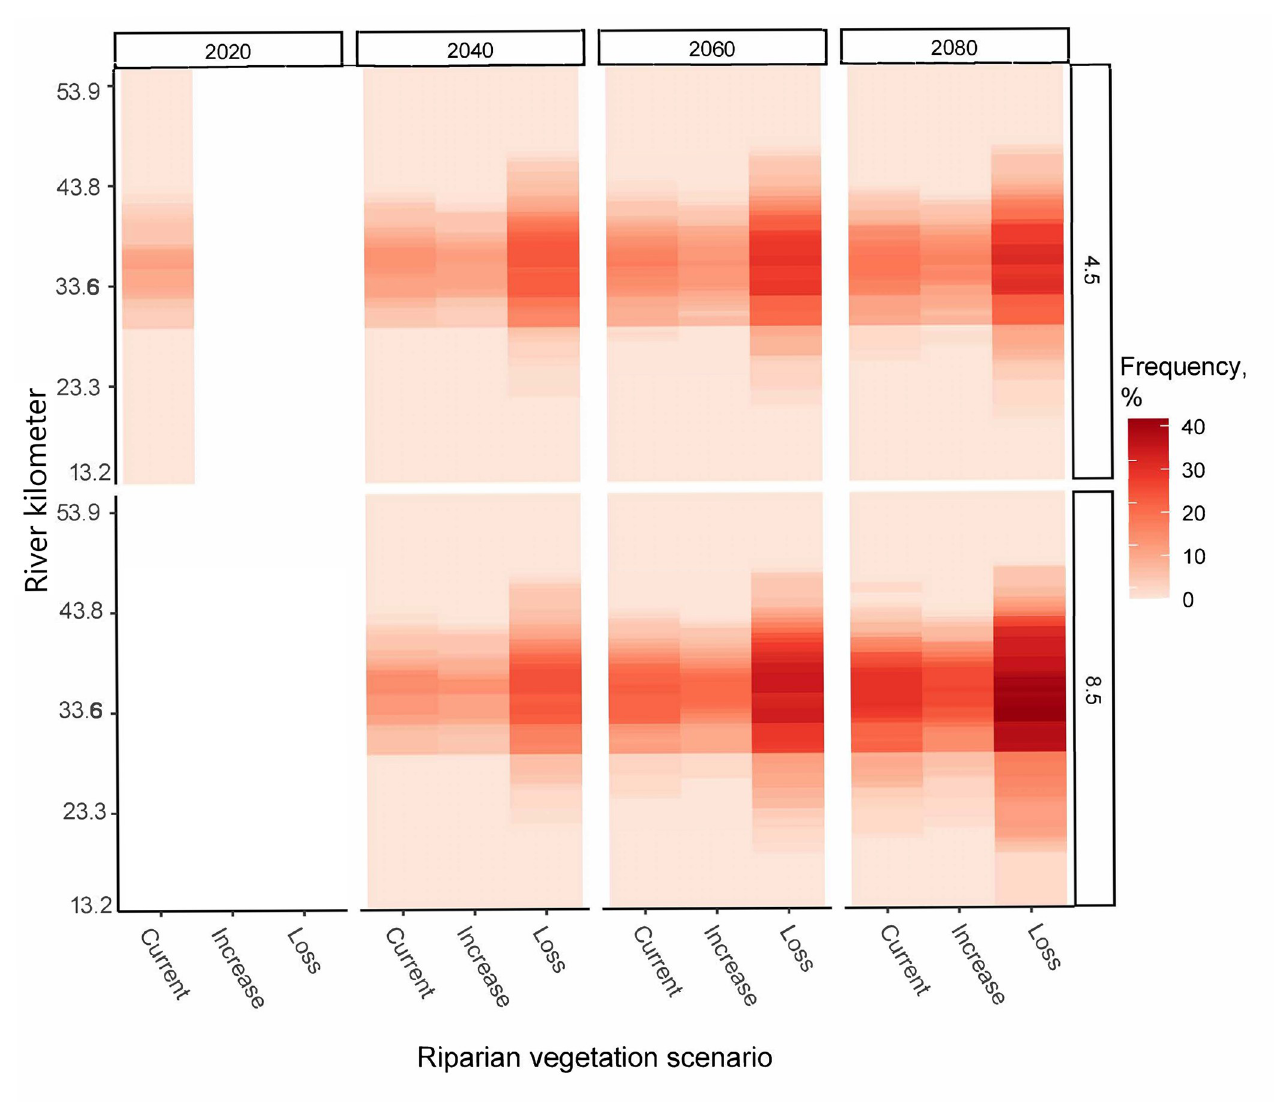
Fig 8. Frequency of predicted lethal water temperature exceedances. Exceedances predicted for adult and juvenile Pacific salmon (non-species specific) [11], in the lower Quinault River (RK 13.2 to 53.9) predicted under future carbon emission projections, RCP 4.5 and 8.5, and riparian shading scenarios during the summer season using a Heat Source water temperature model. Frequency is calculated as the percentage, %, of days with a maximum temperature greater than 24˚C at a specific kilometer.